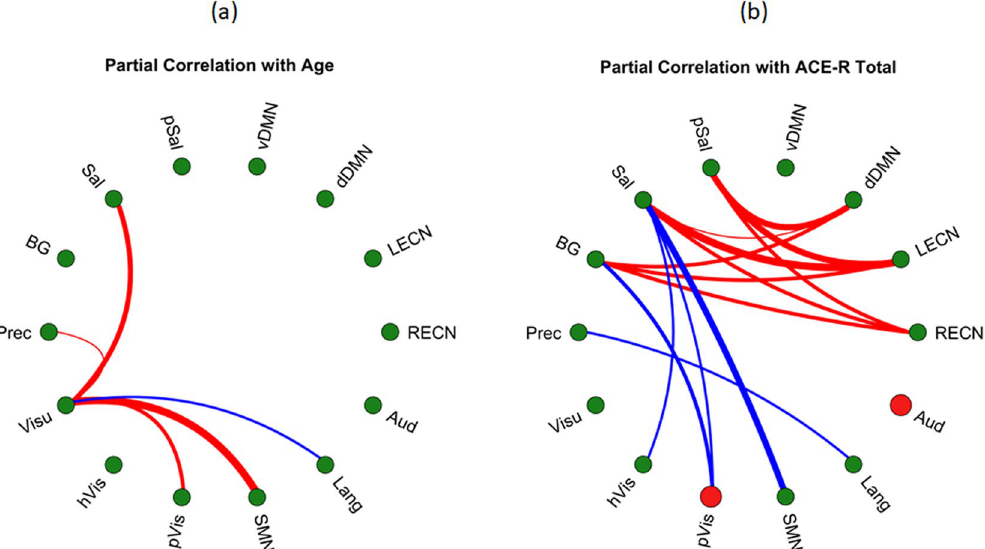
Figure 4. Network graphs showing the correlation between ( a ) network-level functional connectivity and age as well as ( b ) network-level functional connectivity and ACE-R total score. Only significant (FDR q < 0.05) partial correlation values are indicated. Red nodes in ( b ) indicate significant positive partial correlation of within-network functional connectivity (WNFC) with ACE-R total score, while green nodes in both ( a , b ) indicate no correlation. Red links between two nodes indicate significant positive partial correlation of between- network functional connectivity (BNFC) with either age ( a ) or ACE-R total score ( b ), while blue links indicate significant negative partial correlation. Line thickness represents the relative strength of the correlation. SMN – sensorimotor network; RECN – right executive control network; Aud – auditory; BG – basal ganglia; dDMN – dorsal default mode network; HVis – high visual; Lang – language; LECN – left executive control network; pSal – posterior salience; Prec – precuneus; PVis – primary visual; Sal – salience; vDMN – ventral default mode network; Visu –